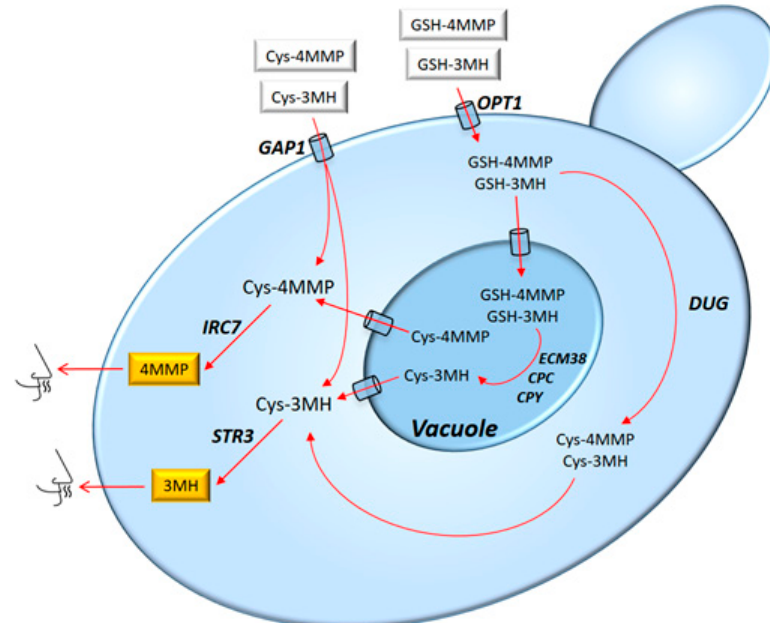
Figure 5. Metabolic and gene regulation of the production of varietal thiols. The uptake of the precursors is mediated by general amino acid transporters. Gap1p and Opt1p transporters are responsible for the uptake of the major part of the cysteinylated and glutathionylated precursors, respectively. Once inside the cell, the cysteinylated precursors are cleaved by a carbon-sulphur β -lyase enzyme. Glutathionylated precursors, which enter the cell through Opt1p, are not cleaved directly, but they are degraded to the cysteinylated form as an intermediate in a multi-step pathway.